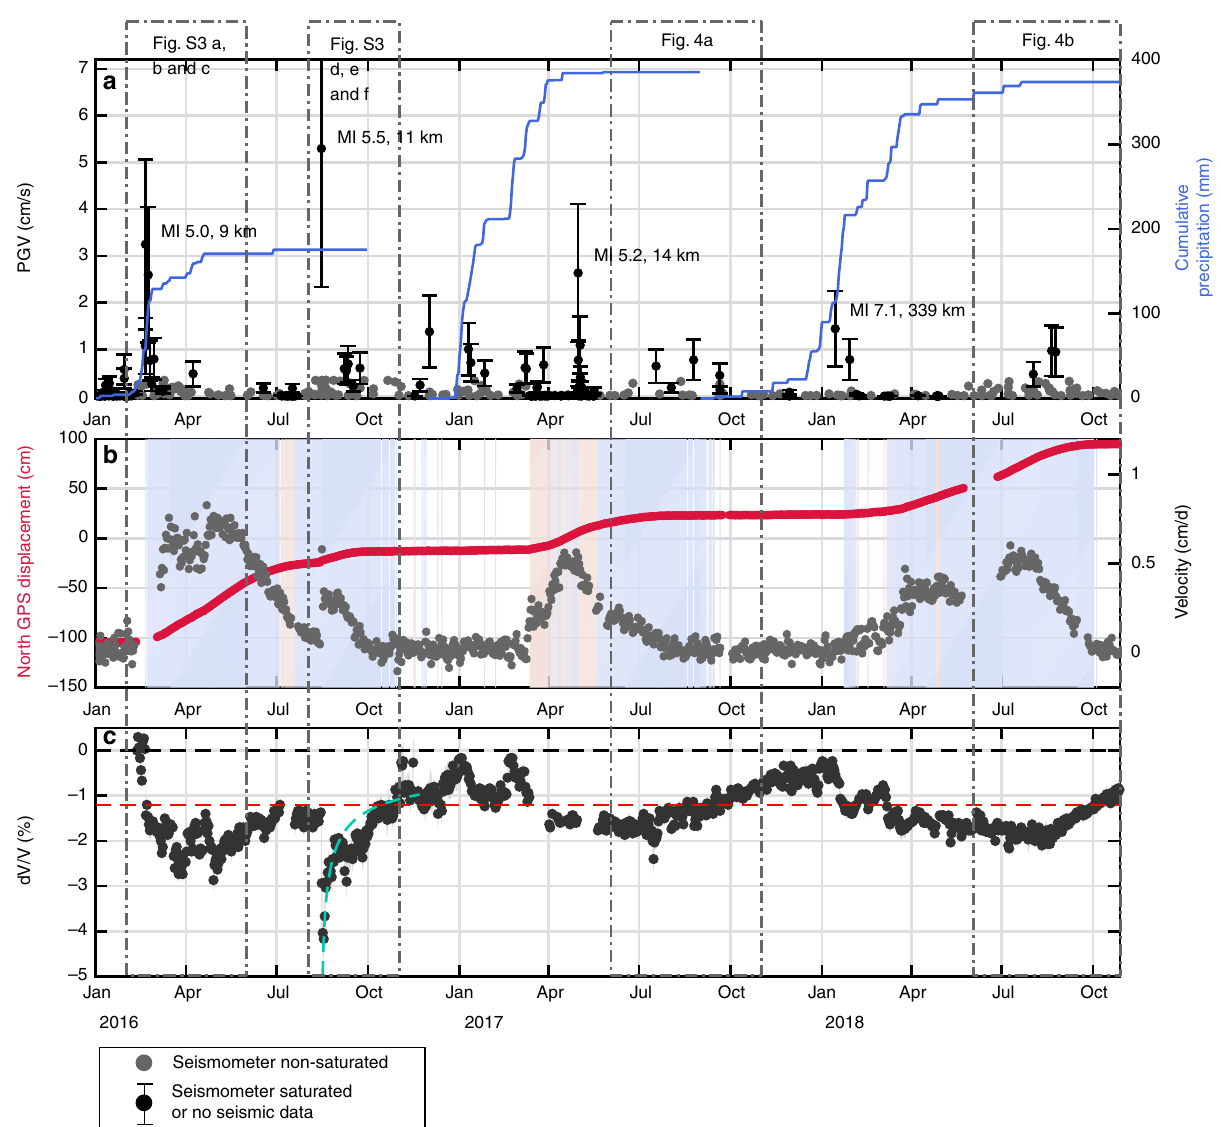
Fig. 2 Comparison of landslide displacement and dv/v induced by earthquakes and precipitation. a Seismicity reported by the Peruvian Geophysical Institute (IGP) for earthquakes with PGV above 0.01 cm.s − 1 (see SI) on the landslide (gray dots), and cumulative rainfall over the rainy season (solid blue line). Earthquakes strong enough to saturate the seismometer located on the landslide or earthquake where no records were available due to problems with the seismometer are indicated by black dots. For signi fi cant earthquakes, magnitudes and distances to the Maca landslide were indicated. b Time series of the Maca GPS North cumulative displacement (red) and velocity (gray) at a 1-day sampling rate. Blue zones represent periods were the dv/v in under − 1.2%, and red zones represent periods were the dv/v is likely under − 1.2% but gaps in the seismic data exist. c Changes to relative seismic velocity of the material determined by comparing daily seismic noise correlograms in the 3 – 8 Hz frequency range (black), which have a depth sensitivity of up to 40 m (see Supplementary Figs. 12 and 13). Gaps in the dv/v time series correspond to missing records. The horizontal black dashed line is the surface wave velocity on the fi rst day of our study period. The red horizontal dashed line is an empirical threshold used in the text ( − 1.2%) under which the landslide is in a critical state. The logarithmic green curve represents the recovery function proposed by Richter et al. 48 . Boxes indicate part of the graphic that has